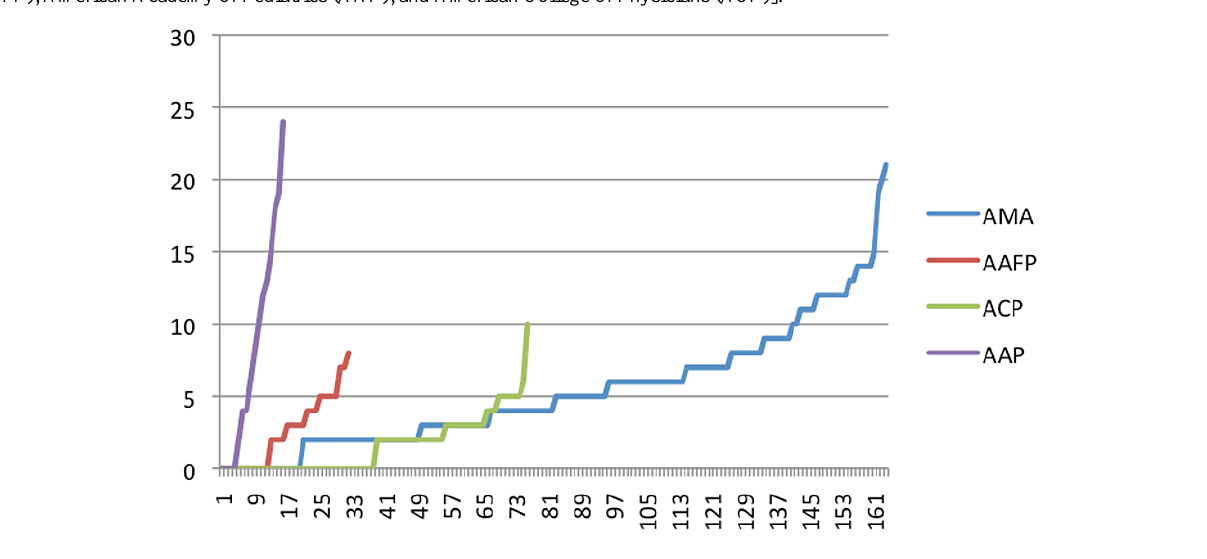
Fraction of information